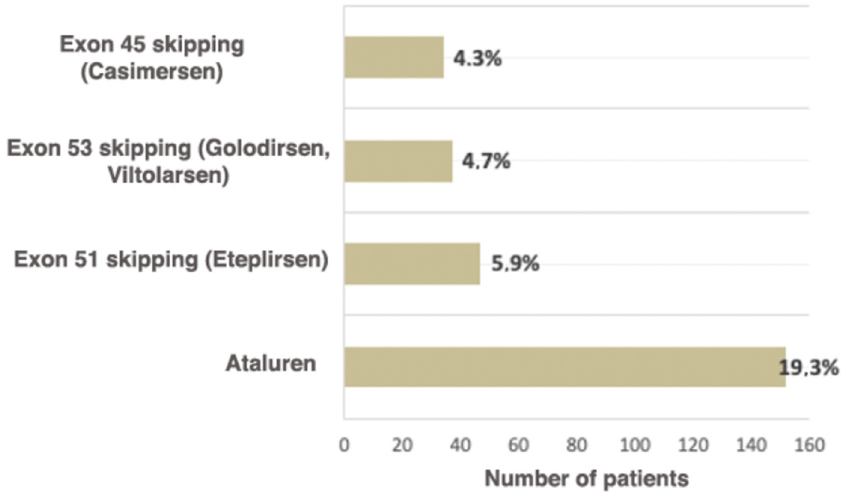
Figure 5. Russian patients eligible for available therapeutic approaches correcting specific mutation types.